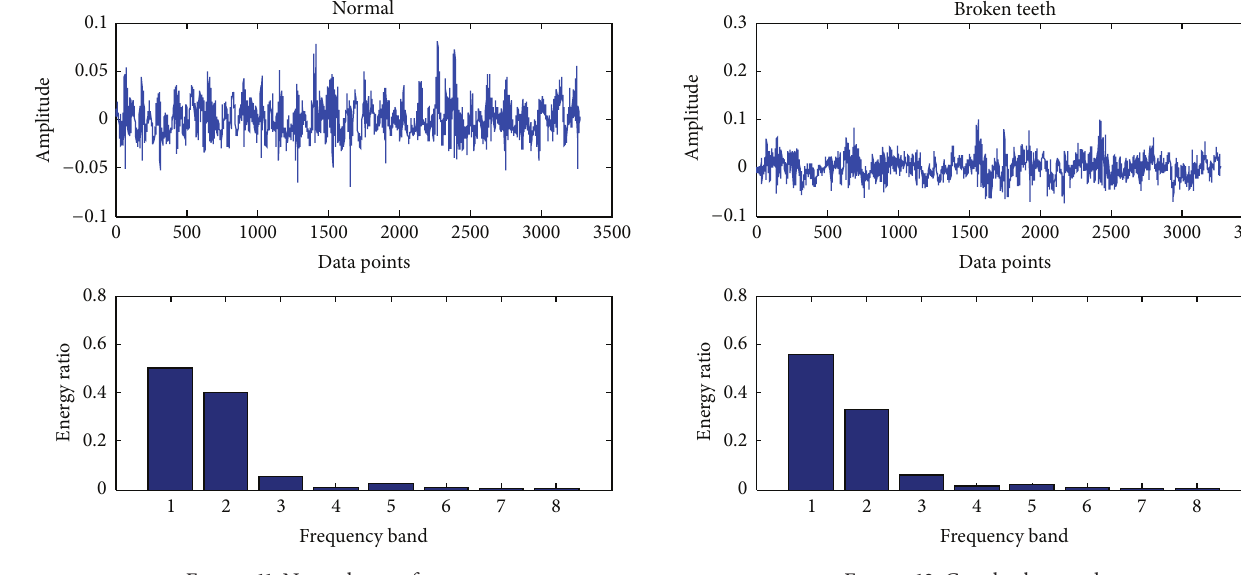
Figure 11: Normal case of a gear. Figure 12: Gear broken